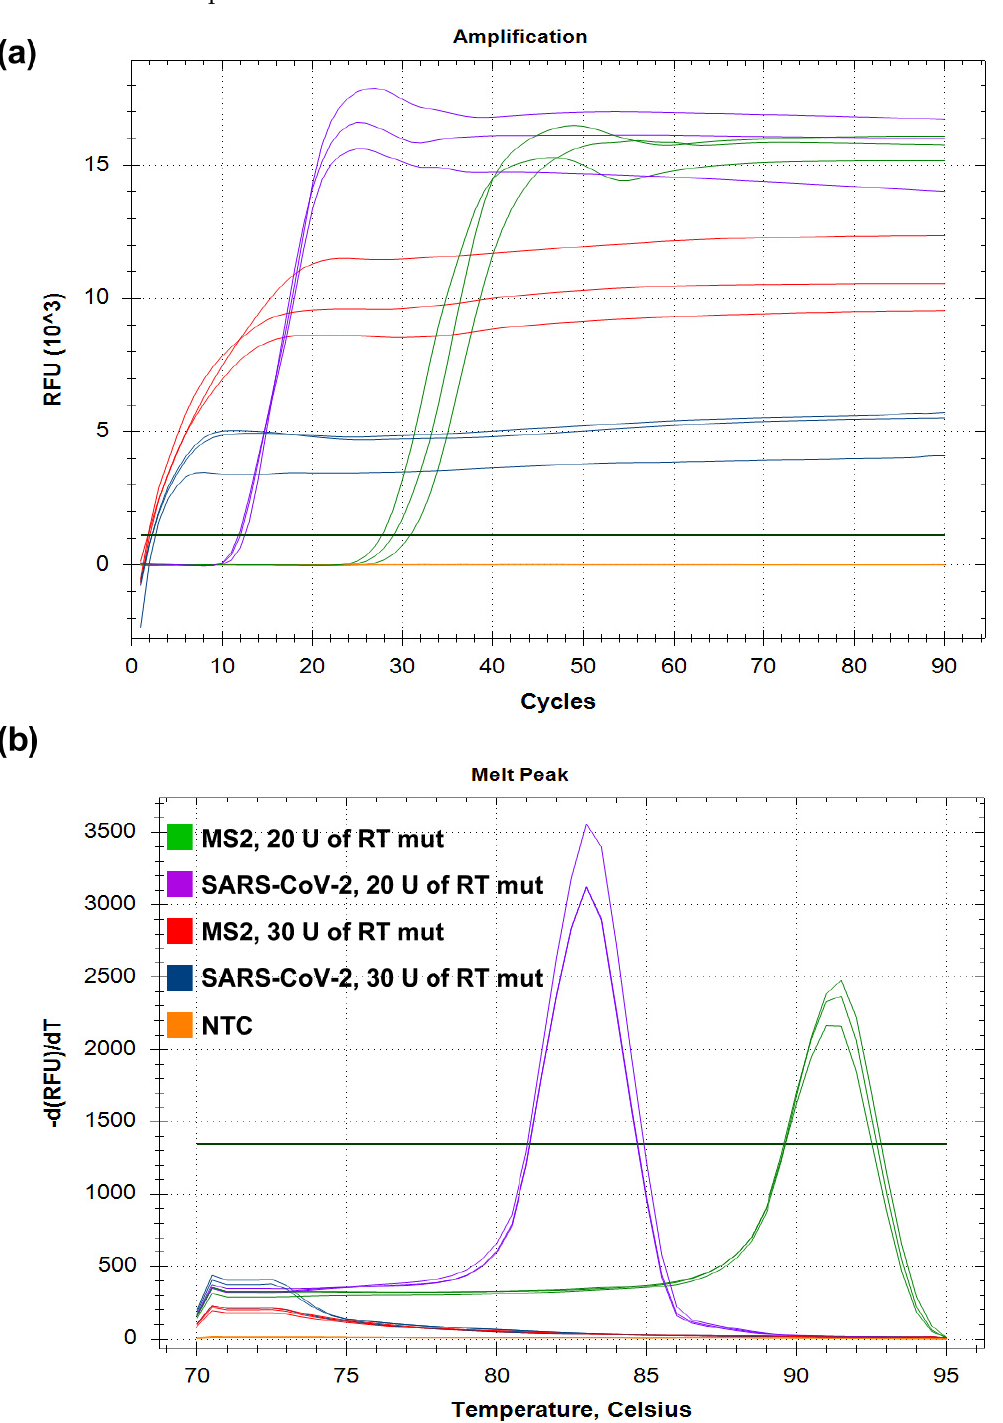
Figure 2. RT-LAMP plot with amplification curves ( a ) and melting analysis ( b ). The temperature of the reverse transcription step was 42 ◦ C. SARS-CoV-2 RNA fragment and MS2 genomic RNA were added in reactions to a final concentration of 10 3 copies per reaction. RT-LAMP for MS2 with 20 U of RT mut is marked in green, and RT-LAMP for SARS-CoV-2 with 20 U of RT mut is designated in violet. RT-LAMP for MS2 with 30 U of RT mut is marked in red, RT-LAMP for SARS-CoV-2 RT-LAMP for MS2 with 30 U of RT mut is designated in blue, and NTC is marked in